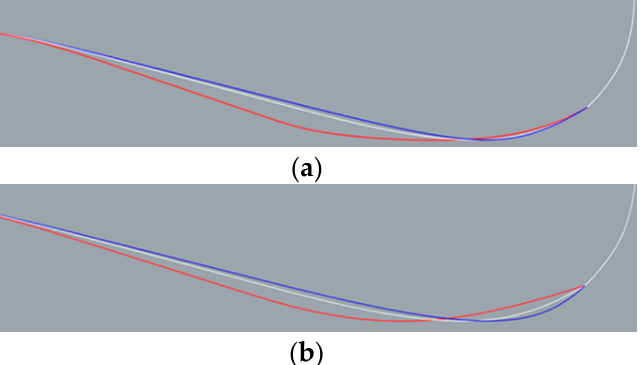
Figure 6. Step (2) result: 𝜃 = 14.113 ° (red line), 14.967 (white line), and 18.718° (blue line). ( a ) Type A and ( b ) Type B.